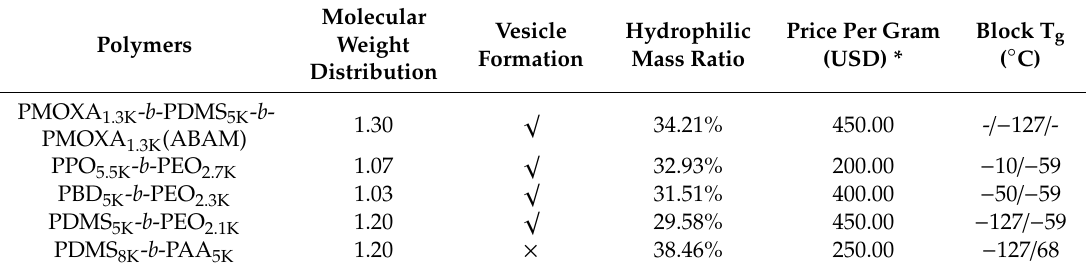
Table 1. Physical properties and assembly behavior of the block copolymers used in this study. Molecular Polymers Weight Distribution